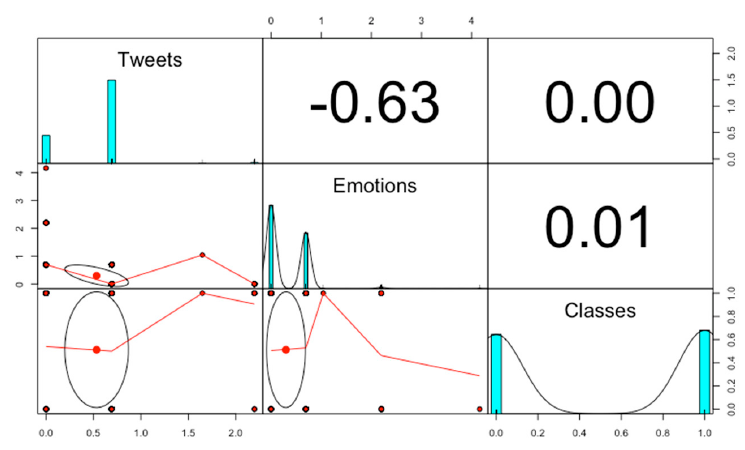
Figure 4. Correlation among emotion tweets in a dataset.